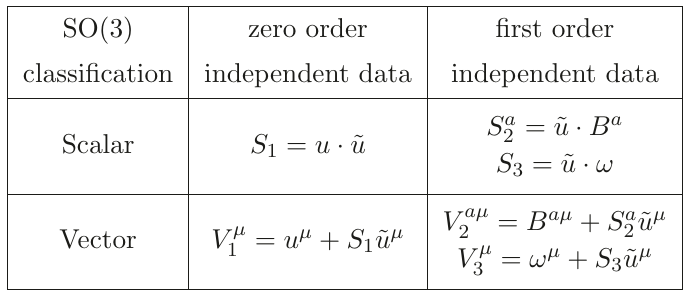
Table 2 . One derivative data contributing to chiral drag